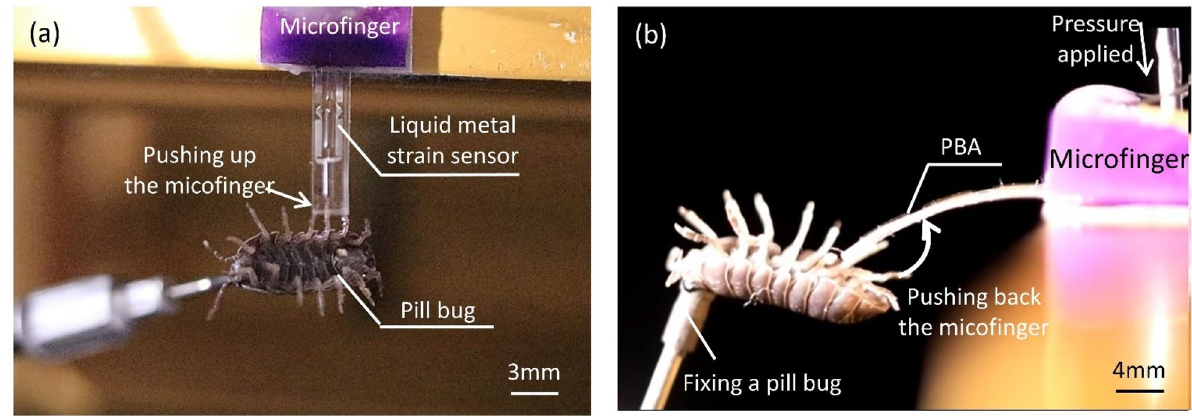
Figure 4. Force measurement of a pill bug by a microfinger. ( a ) Active sensing of leg force. ( b ) Active sensing of abdominal force. The pill bug was immobilized by vacuum tweezer device. The attitude angle of a pill bug was adjusted for optimum contacts against the leg and body. The generated force by a microfinger was 15.6 mN at 140